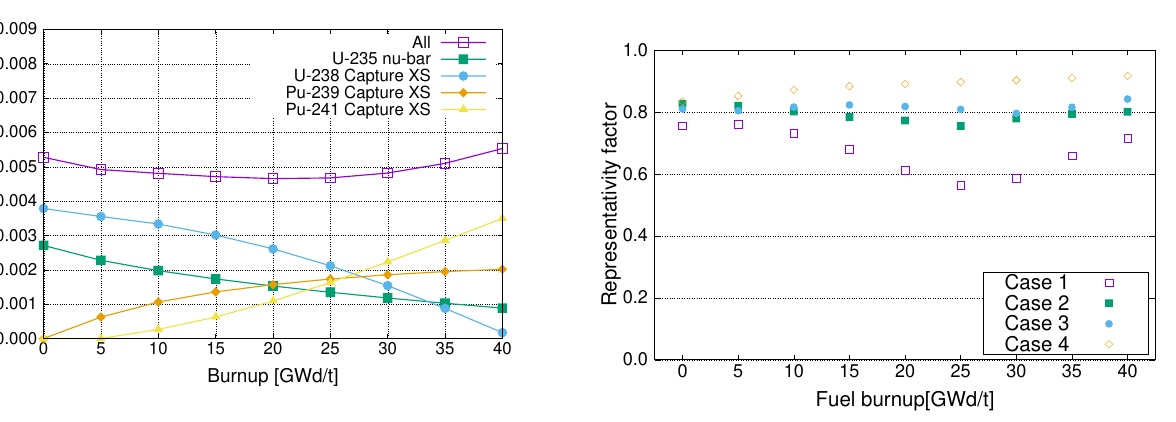
Figure 3. Maximum RFs of nuclide inventory